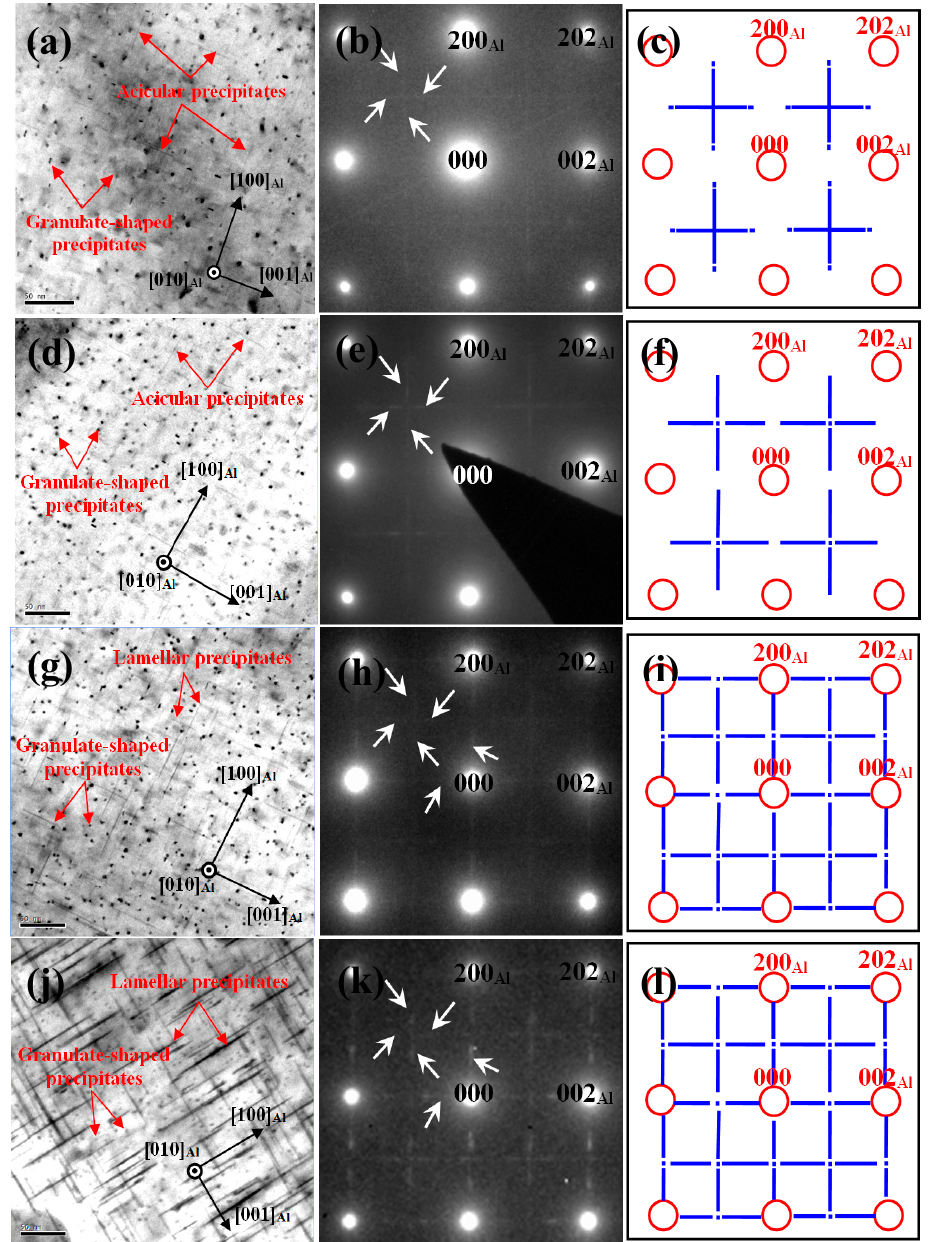
Figure 11. TEM and SADP images of the four peak-aged Al-Mg-Si-Cu alloys observed in the <010> Al projection: ( a,b,c ) Alloy 1, ( d,e,f ) Alloy 2, ( g,h,i ) Alloy 3, ( j,k,l ) Alloy 4.